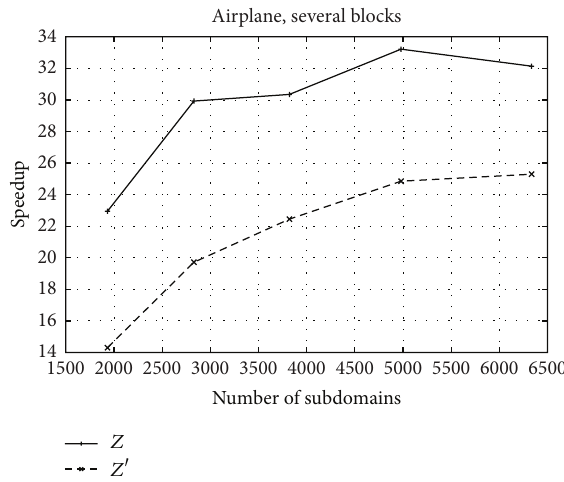
Figure 11: Speedup when dividing the airplane geometry in several blocks.